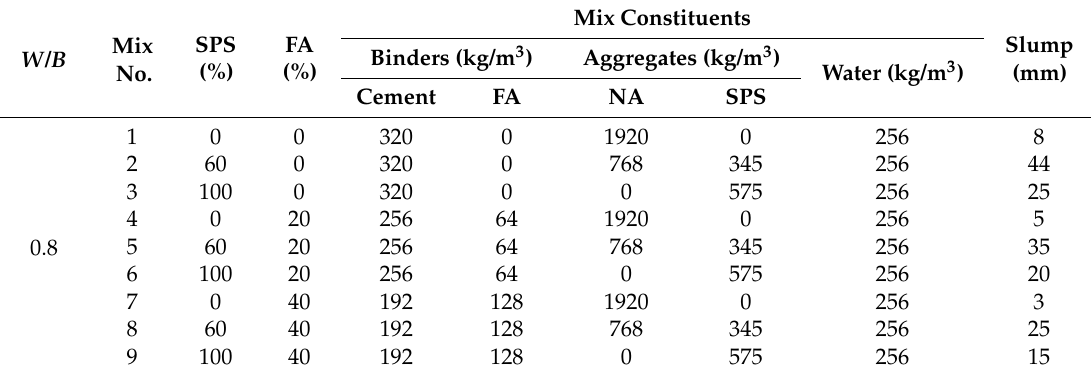
Table 3. Details of concrete